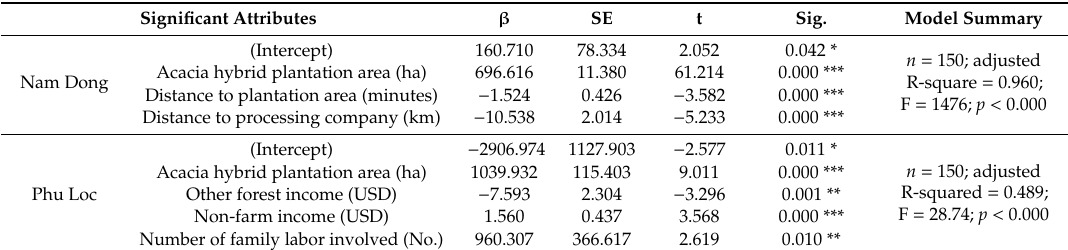
Table 7. Determinants of Acacia hybrid timber income of producer households in Nam Dong and Phu Loc districts.